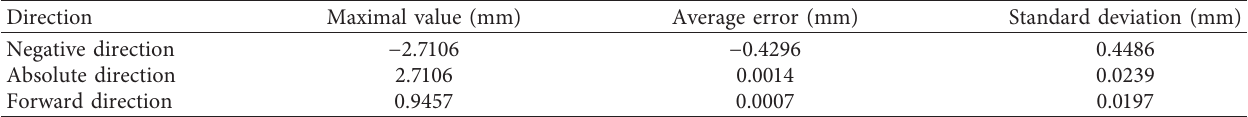
Table 7: Evaluation and analysis of the point cloud by our proposed method for Figure